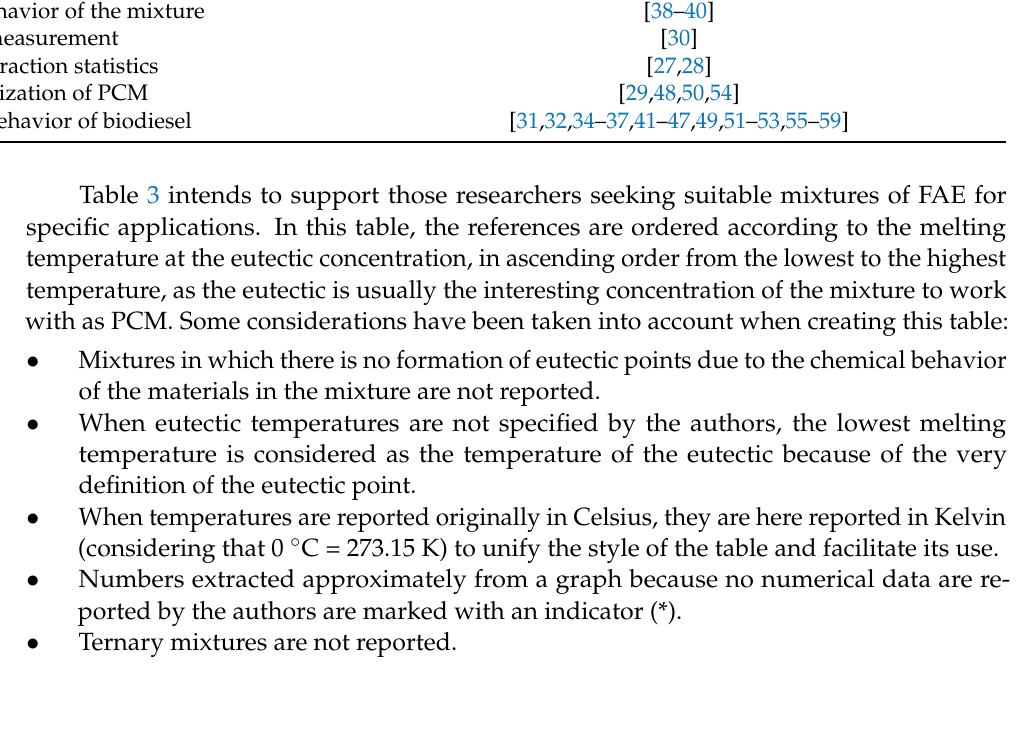
Table 2. References grouped by the main purpose of the study. Purpose of the